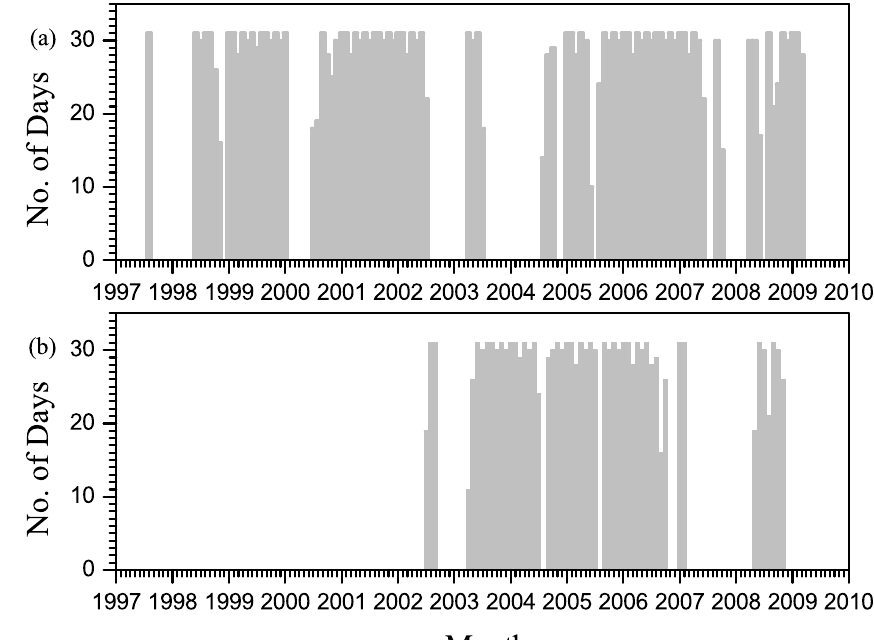
Fig. 1. Number of days are available from each month (a) for Resolute Bay (RB) (from July 1997–February 2009), (b) for Yellowknife (YK) (from June 2002–October